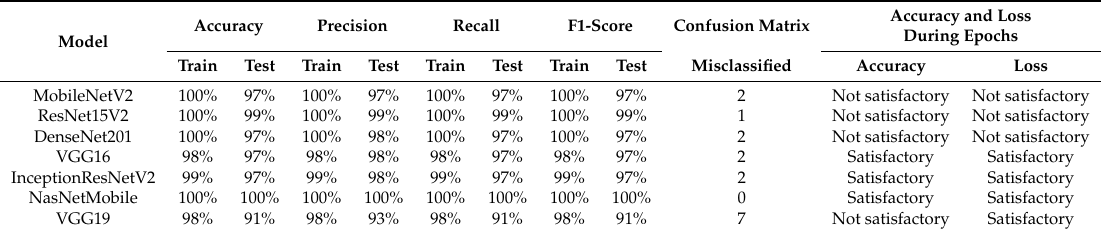
Table 8. Overall summary of the best model found considering various factors on chest X-ray image dataset.